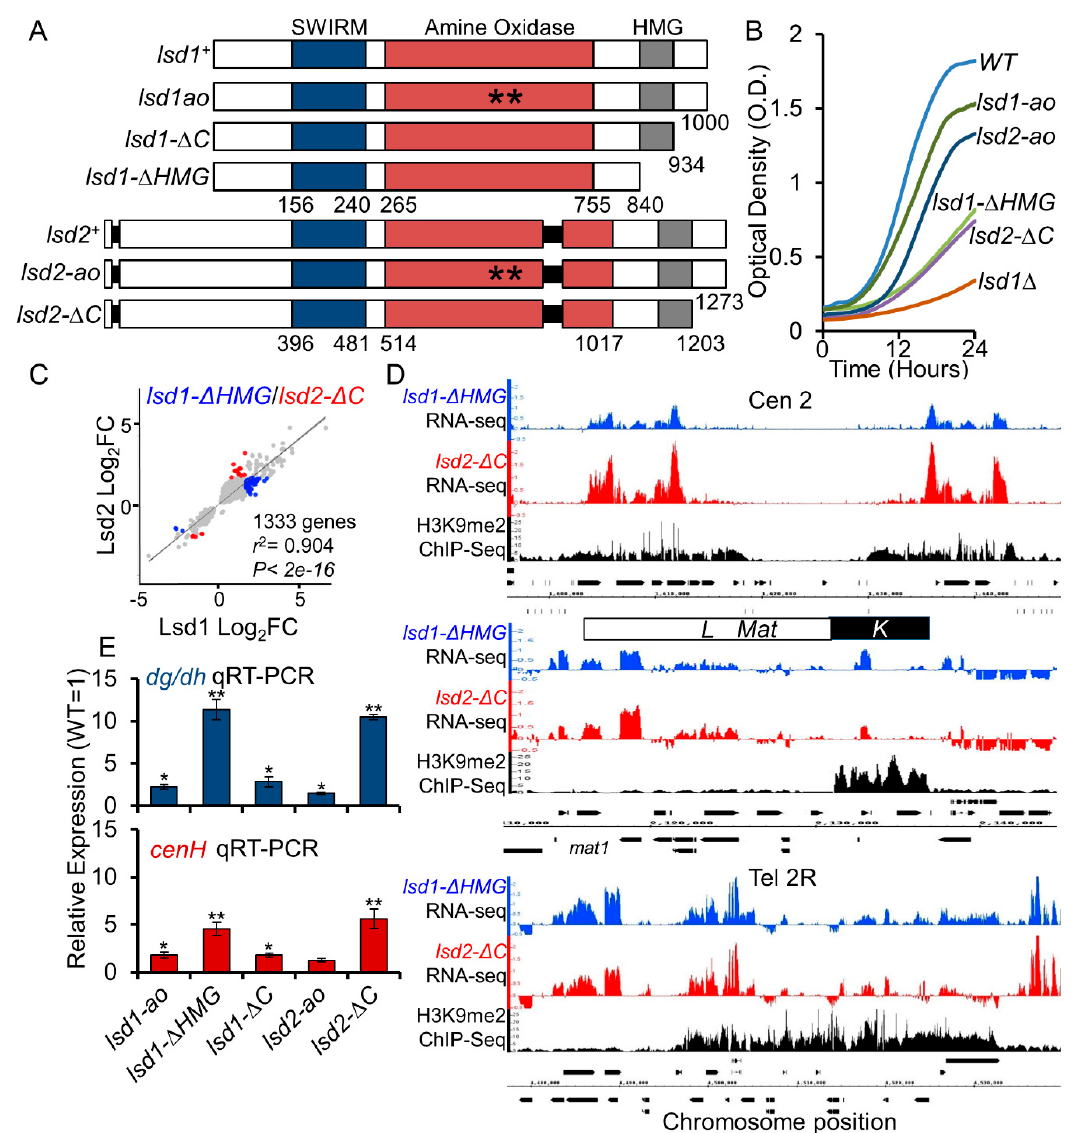
Figure 2 . The C-terminal domains of Lsd1 and Lsd2 are vital for proper growth and genome-wide gene expression. ( A ) Schematic representations of WT Lsd1 and Lsd2 compared to catalytically inactive and C- terminal truncated mutants. ( B ) Growth curves generated by a plate reader show the growth rates of indicated WT, lsd1 , and lsd2 mutants over a 24 hour period. ( C ) Comparison of DEGs between lsd1- Δ HMG and lsd2- Δ C using linear regression analysis. ( D ) Loss of silencing at peri-centromeric region, mating type locus, and sub- telomeric region in lsd1- Δ HMG and lsd2- Δ C compared to WT. Cen 2: Centromere II. Mat : Mating-type locus. Tel2R: right telomere II. Normalized RNA-seq reads are aligned with H3K9me2 enrichment as measured by ChIP, which indicate heterochromatic regions. Data are plotted along with chromosome position. ( E ) qRT-PCR analysis of the silenced dg/dh repeats in the peri-centromeric region and cenH ( mat locus). * p ≤ 0.05 and ** p ≤ 0.01 as determined by student’s t test comparing the indicated samples with WT. Error bars represent s.e.m.